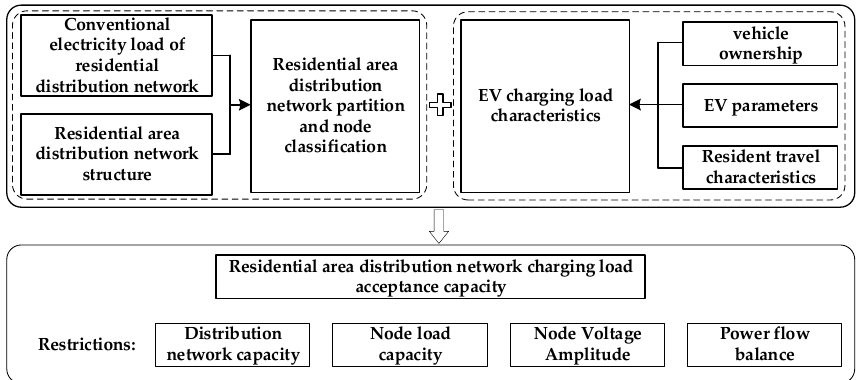
Figure 1. The scheme of the acceptance capacity analysis of EV charging